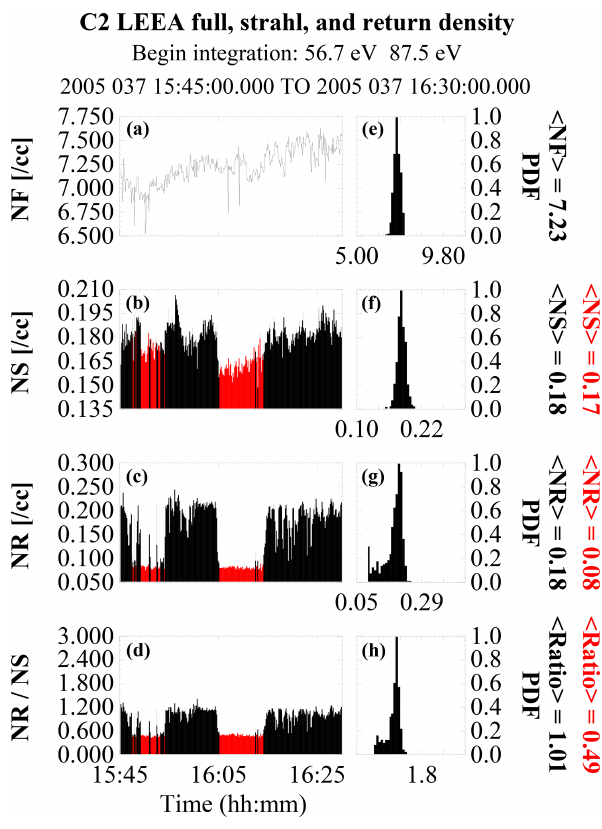
Figure 10. Electron density information across the 6 February 2005 event. From top to bottom are the total, strahl, and return electron densities and the ratio of the return to strahl density across the event. Panels (a–d) show the values as a function of time. The red por- tions in (b–d) show when the spacecraft was in the solar wind. Pan- els (e–h) are the corresponding PDF plots of the foreshock density only. The average foreshock and solar wind densities are shown to the right of each PDF plot (red solar wind, black foreshock). The beginning energy integration used to estimate the density in each region is shown at the